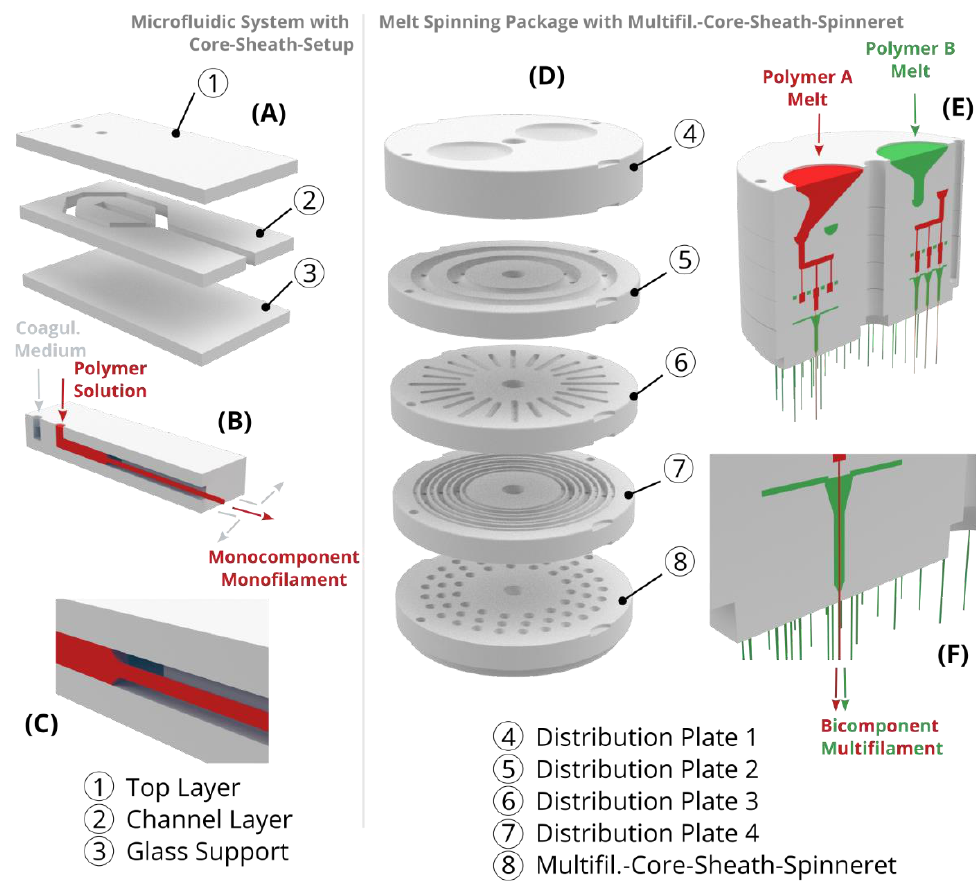
Figure 6. Schematic representation (left) of a microfluidic system with core-sheath-setup consisting of 3 layers, ( A ) shown as exploded view, ( B ) sectional view, and ( C ) detailed view. The inlet and the flow of the coagulation medium (gray-blue) and the polymer solution (red) of the microfluidic system are illustrated. At the exit, the polymer solution is coagulated into a monofilament and the coagulation medium flows off to the side. Schematic representation (right) of a melt spinning package with a multifilament-core-sheath-spinneret, ( D ) shown as exploded view, ( E ) sectional view, and detailed view ( F ). The inlet and the flow of the polymer A (red) and the polymer B (green) of the melt spinning package are illustrated. At the exit, both polymers are coaxially combined to form several bicomponent filaments (multifilament).